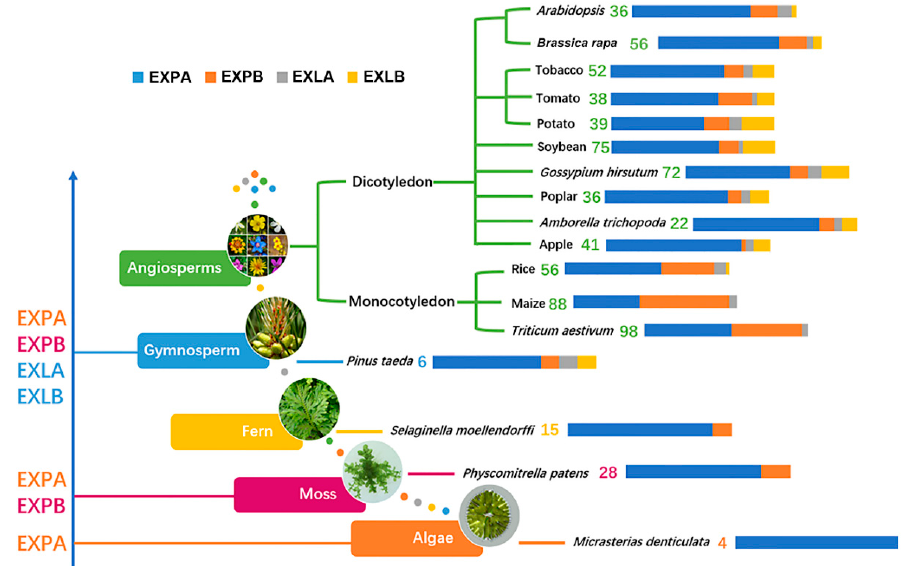
Figure 1. Evolutionary analyses of expansin genes, numbers of family members, and proportions of di ff erent subfamilies in representing species. Di ff erent subfamilies emerged at di ff erent periods during evolution, with appearance times indicated by blue arrows on the left. Expansin family members are shown for di ff erent species, with changes in the proportions of di ff erent subfamilies. Di ff erent bar lengths represent di ff erent proportions of subfamilies. The numbers of family members in representative species are from reported studies. References are the same as in Table